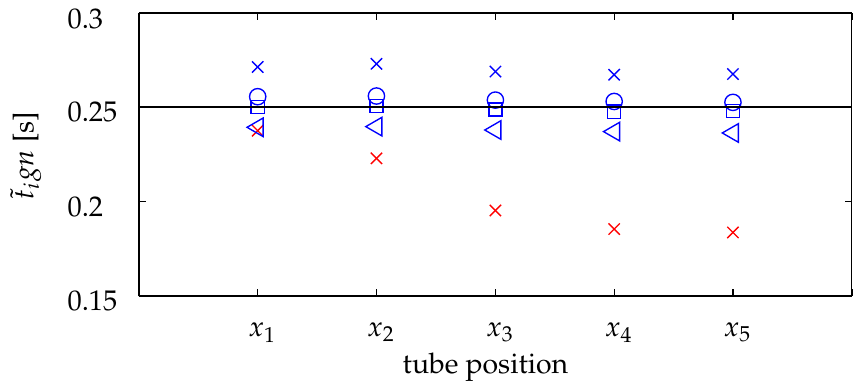
Figure 7. Example of five time-resolved combustion processes. Red : Injection profile and detected ignition times with initialized control trajectory; Blue : Injection profile and detected ignition times with converged control trajectory (ignition number 401–404). The four consecutive shots have the same injection profile. Their individual ignition timings are depicted with different markers.